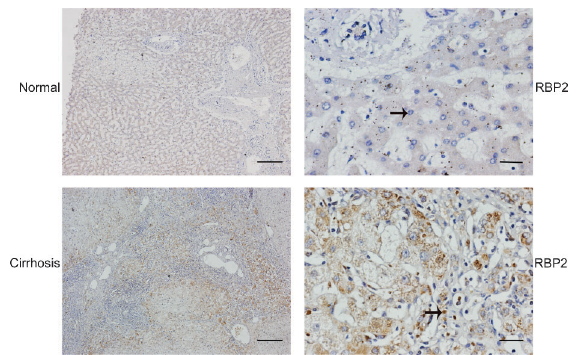
Figure 1. The expression of retinoblastoma binding protein 2 (RBP2) is upregulated in cirrhotic livers. The arrows show the negative (normal) and positive (cirrhosis) cells. Magnification bars=40 m m (left panels) and 10 m m (right